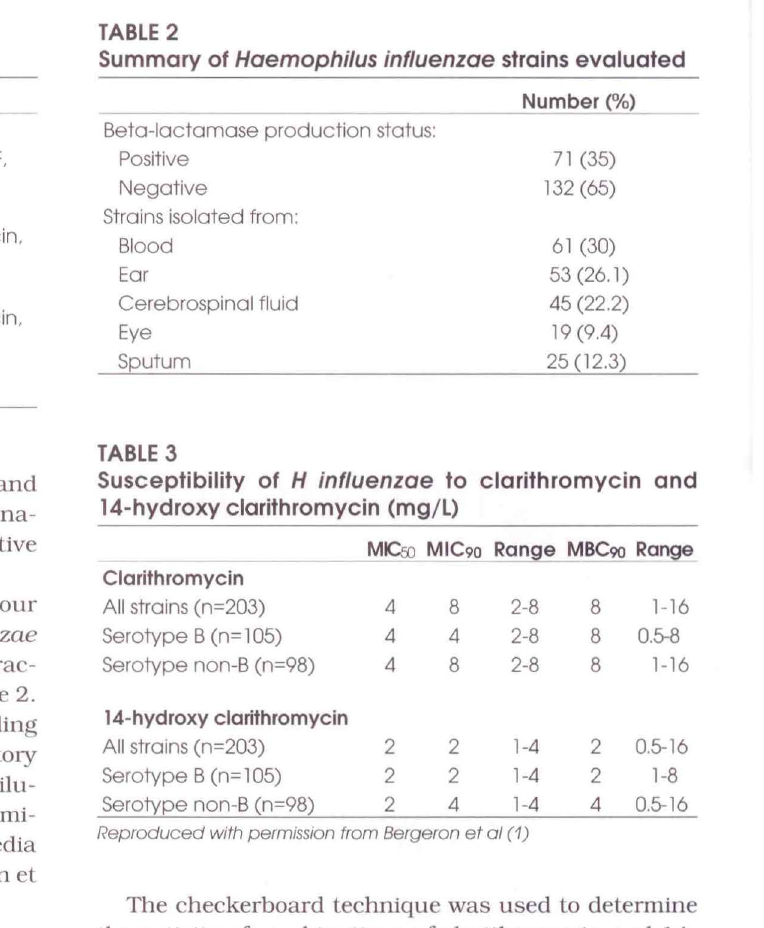
In vitro effect of the combination of clarithromycin and 14-hydroxy clarithromycin against H influenzae by